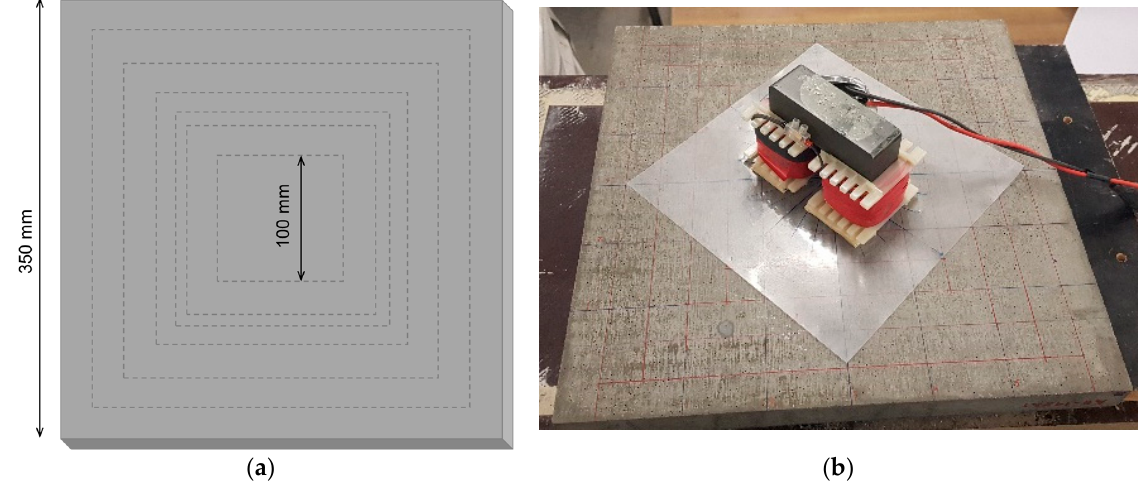
Figure 6. ( a ) Successive reduction of plate size; ( b ) Inductance measurements in the centre of the plate (original size).